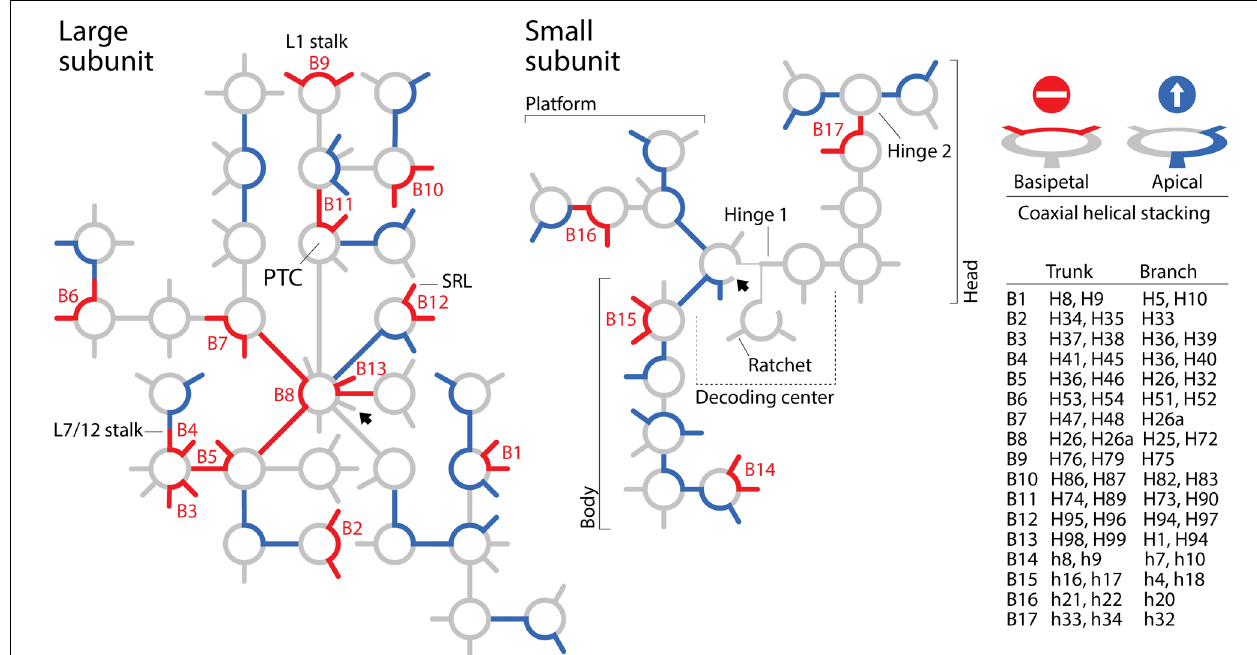
FIGURE 2 | Roadblocks to apical growth. Patterns of coaxial helical stacking in rRNA define “branch-to-trunk” directionalities that violate the “onion” apical growth model of Bokov and Steinberg (2009) and Petrov et al. (2014). Secondary structure models of the small and large subunits of the Escherichia coli ribosome are depicted with schematic representations of helical tracts (lines) and junctions (circles). Unambiguous coaxial helical stacking regions in three-way and higher order junctions associated with putative sites of insertions (Petrov et al., 2014) were indexed by examining structural models and confirmed by consulting descriptions of others (e.g., Laing and Schlick, 2009; Laing et al., 2009). Coaxial helical stacking